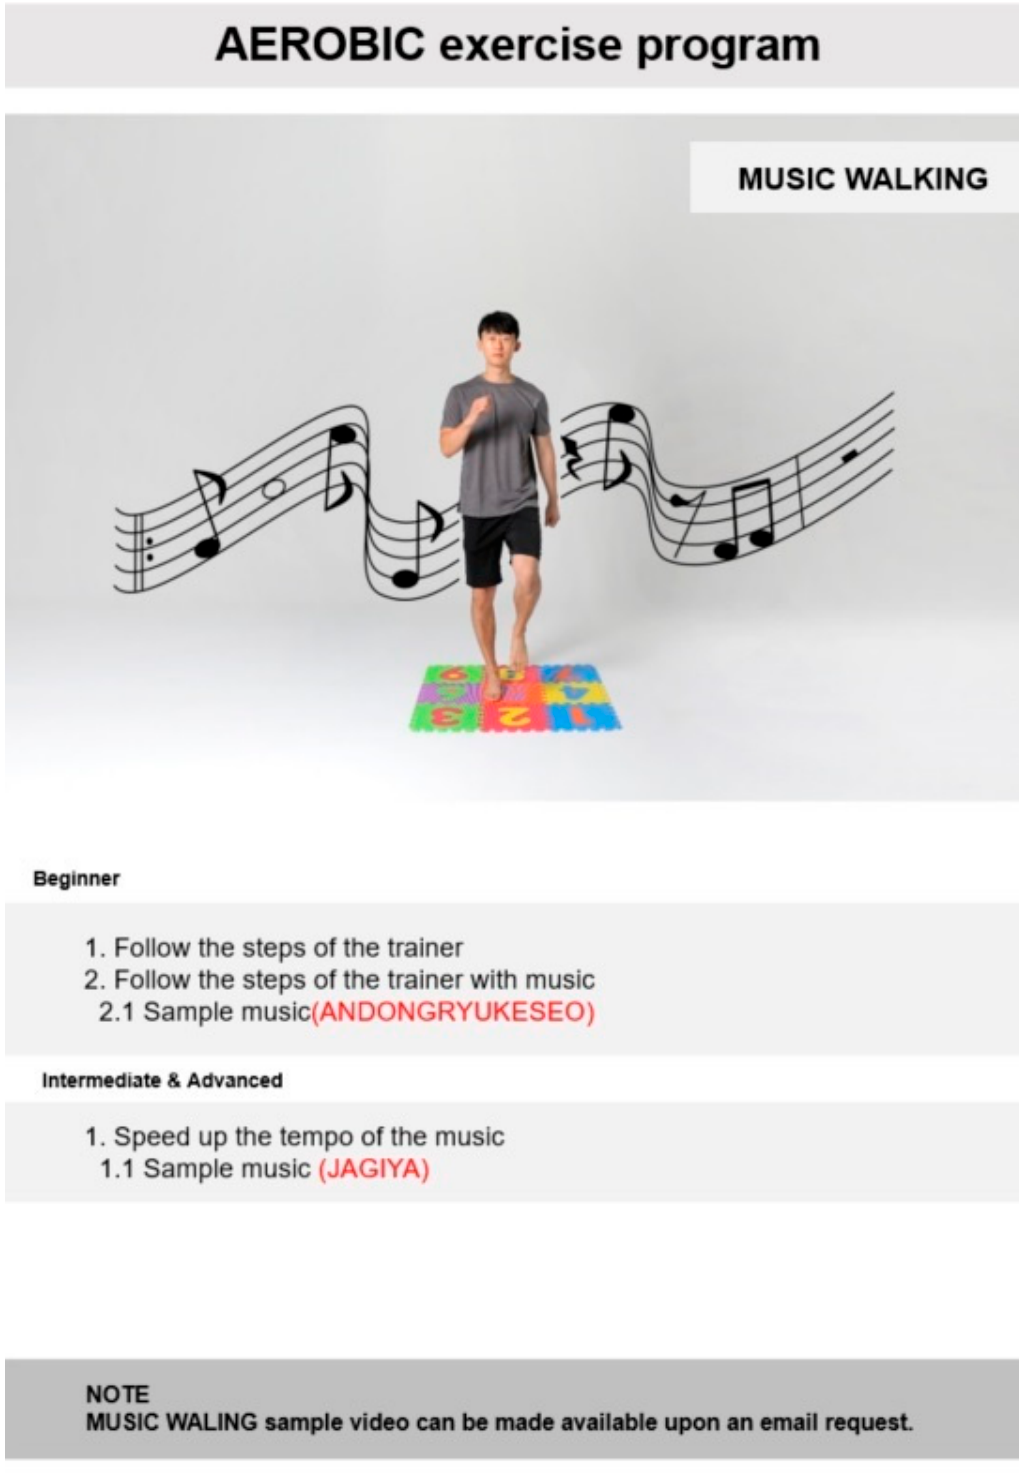
Figure A5. Detailed description and components of each movement in the “Music walking” aerobic exercise.